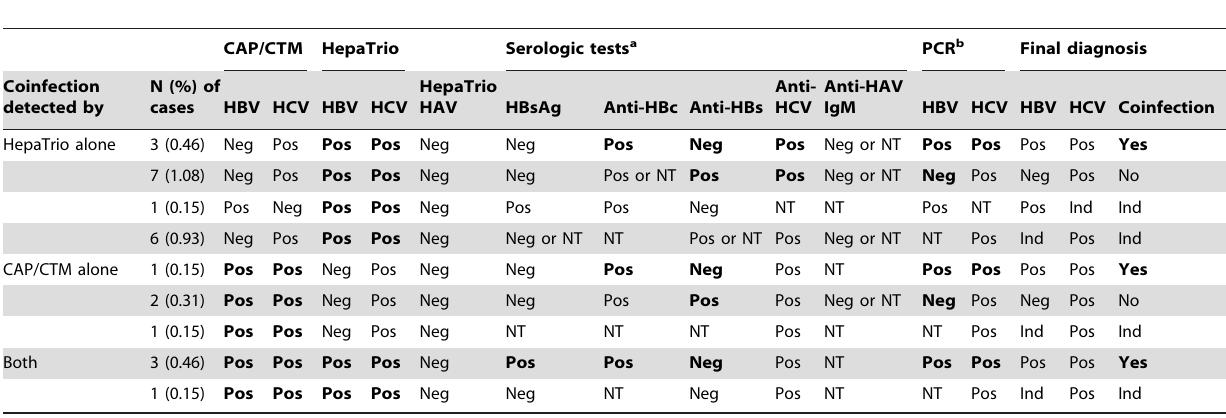
Table 4. Summary of HBV and HCV coinfection cases detected by the HepaTrio and/or the CAP/CTM assays.